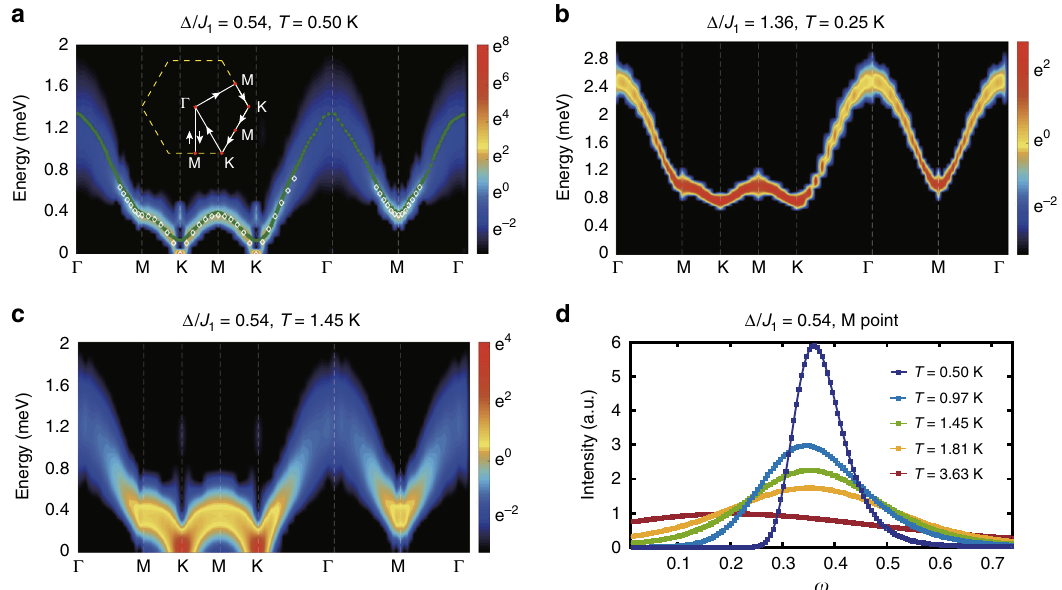
Fig. 4 QMC-SAC spectra of TMGO at fi nite temperature. a Shows the calculated spin spectrum of TLI at T = 0.5 K, with model parameters determined in this work and computed on an L = 36 torus geometry. The computed spectrum agrees excellently with the experimental INS results taken from ref. 26 , whose peak positions are shown as the green dotted line. The white diamonds represent the bottom-part excitation results without resorting to analytical continuation, which agree very well with the QMC-SAC results. The path consists of the Γ -M-K-M-K- Γ loop and a Γ -M- Γ vertical mini-loop, as shown in the inset. b Spectrum with the parameter set given in ref. 26 , which clearly fails to describe the material. In c , we plot in the spin spectra with model parameters in a but at a higher temperature 1.45 K. Compared with a , the K point gap gets smoothed and the rotonlike gap reduced. We collect the M point intensity vs. ω and plot in d , where the linewidth near the rotonlike minima is substantially broadened as T increases, suggesting strong fl uctuations and vortex proliferation in the